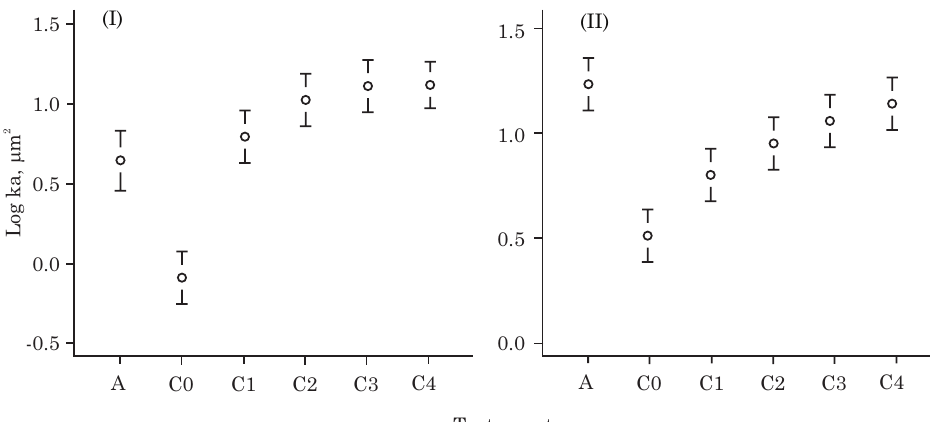
Figura 8. Valores médios de log de permeabilidade ao ar de dois Latossolos Vermelhos distróficos, um argiloso (I) e um franco-argilo-arenoso (II), para os tratamentos A, C0, C1, C2, C3 e C4. As barras representam o intervalo de confiança da média (85 %).